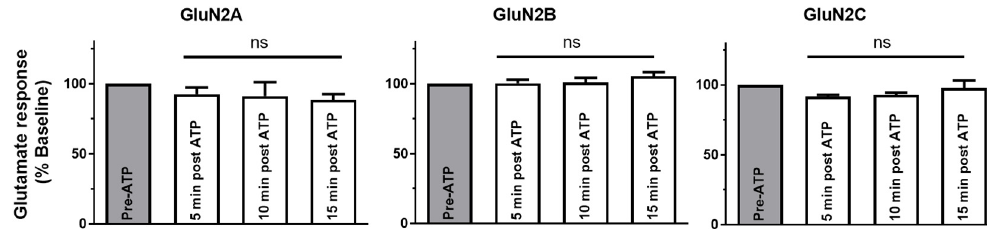
Figure A3. P2X4-mediated NMDAR inhibition depends on the P2X4 CT domain. Bar graphs representing the mean of the amplitude of NMDARs responses in CfRS before and after P2X4-377TR activation by ATP. All values were normalized to the Glu response obtained before P2X4-377TR stimulation. None of the Glu responses after ATP application were statistically significantly different ( p > 0.05) from the baseline response (before ATP application) for any GluN2 subunit. The data are expressed as mean ± SEM. Statistical analysis performed using a one-way ANOVA test.